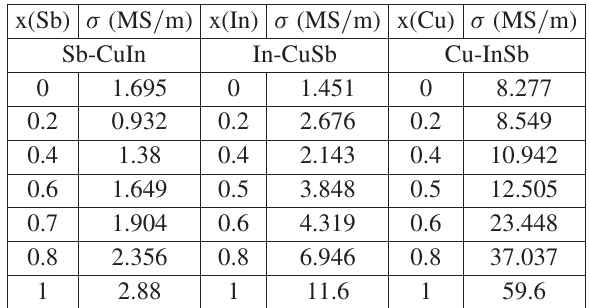
Table 2. Alloys compositions and electric